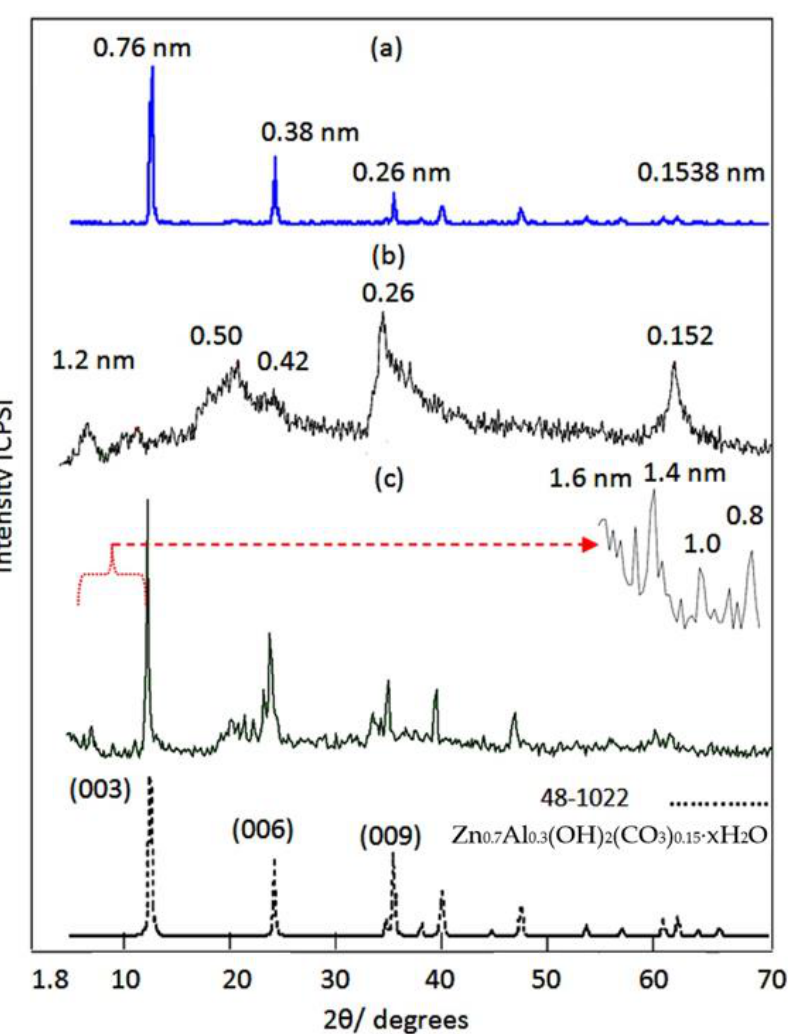
Figure 3. X-ray diffraction patterns of: ( a ) the pure Al/Zn nanolayered structure, ( b ) the nanohybrid ZNH-1 and, ( c ) the nanohybrid ZNH-2. With intercalating longer chains of organic compounds, stearic acid (CH 3 (CH 2 ) 16 COO − ), and the nanoparticles of cobalt iron oxides nanocomposite inside the